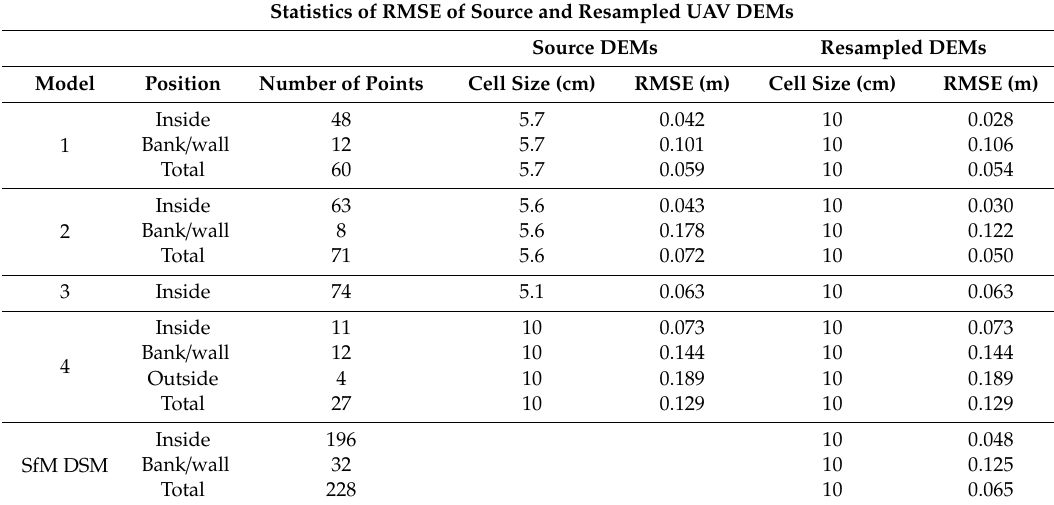
Table 3. RMSE of the source and resampled UAV